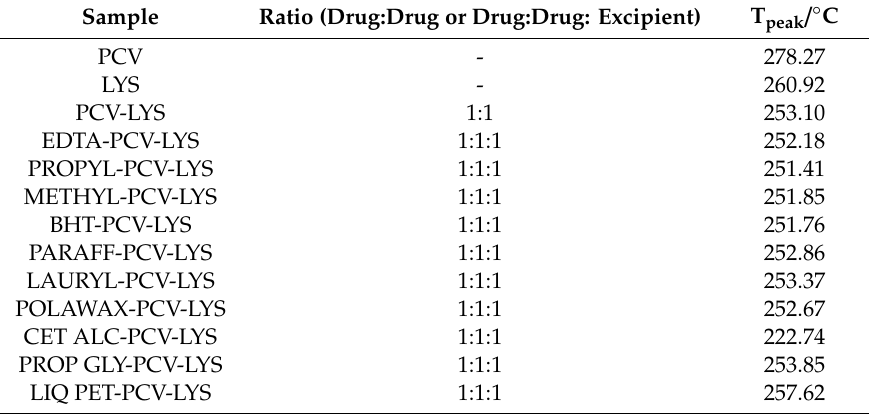
(Figure 6, PROPYL-PCV-LYS and METHIL-PCV-LYS) of these compounds was a superposition of each individual preservative curve and the PCV-LYS curve, with all events separate and well defined, which indicated that there was no interaction between the compounds. Table 2. T peak temperatures of the main event in the DSC curves of PCV, LYS, and binary and ternary mixtures. Ethylenediamine tetra-acetic acid (EDTA), cetostearyl alcohol (CET ALC), sodium lauryl sulphate (LAURYL), di-tert-butyl methyl phenol (BHT), liquid petrolatum (LIQ PET), methylparaben (METHYL), nonionic wax (POLAWAX), para ffi n (PARAFF), propylene glycol (PROP GLY), propylparaben